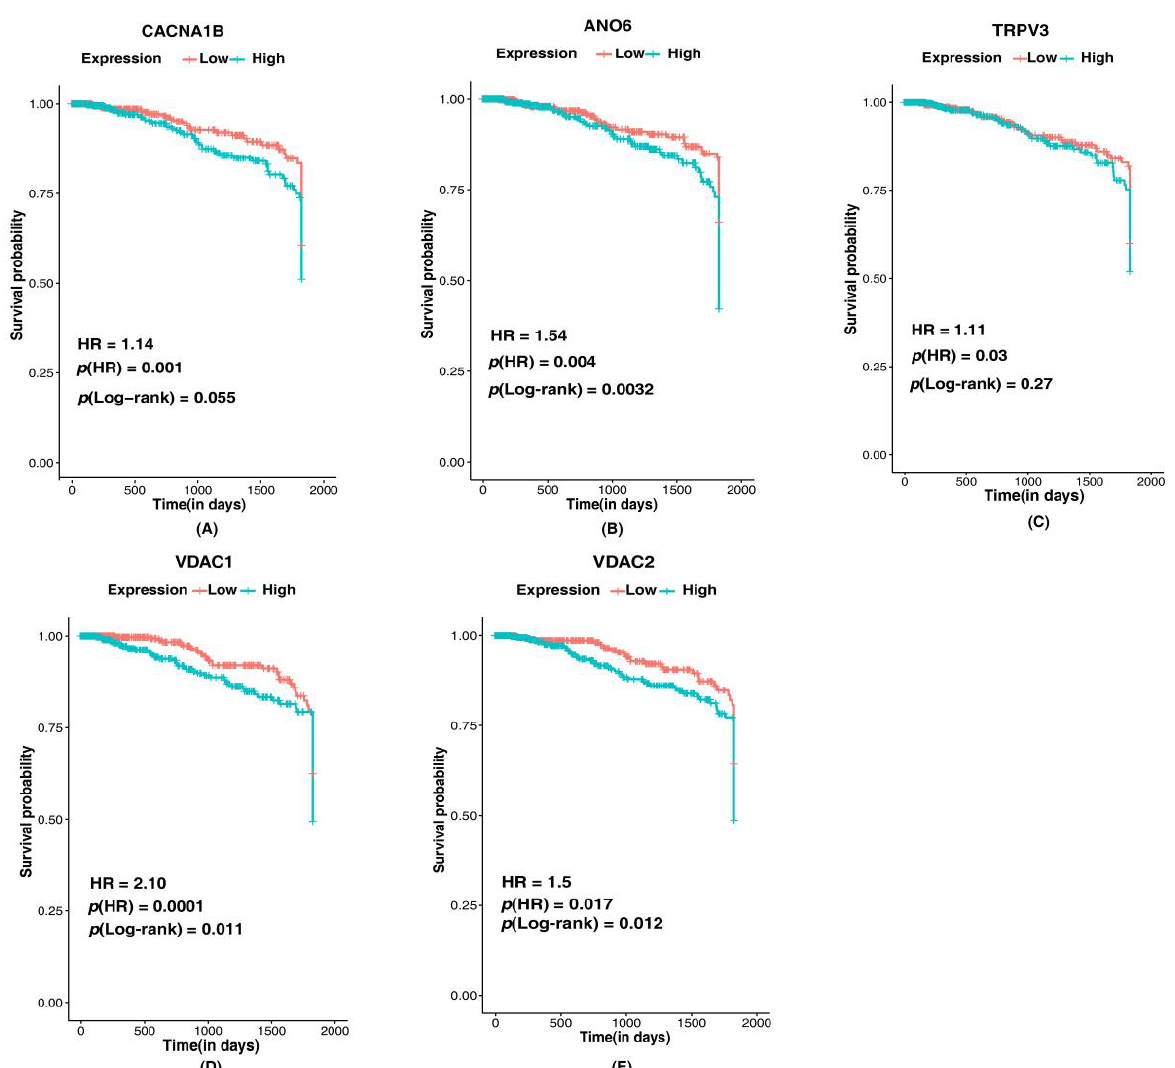
Figure 8. Kaplan–Meier 5-year survival curves representing the prognostic relationship between high and low expression of ion channels identified in breast cancer with survival probability. ( A ) CACNA1B , ( B ) ANO6 , ( C ) TRPV3 , ( D ) VDAC1 , and ( E ) VDAC2 .